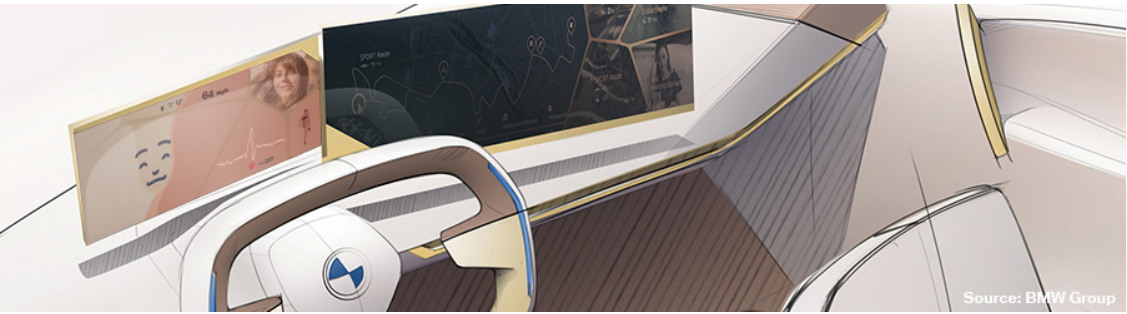
Figure 2. Concept Visual Notification imagines a graphical representation of the driver state on the